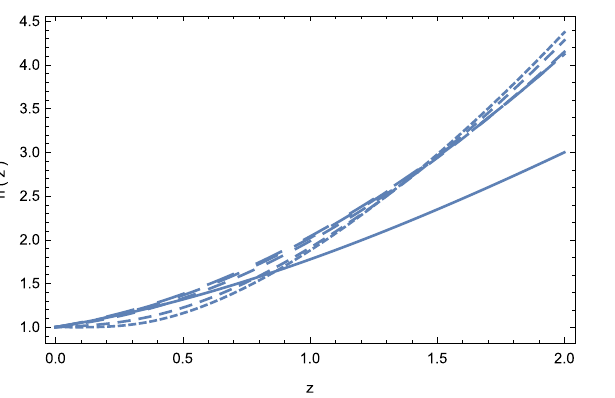
Fig. 6 Variation as a function of the redshift of the matter energy den- sity r ( z ) for the geometry-matter coupling function F for M = 0 . 98, and for different values of α : α = − 0 . 72 (dotted curve), α = − 0 . 77 (short dashed curve), α = − 0 . 80 (dashed curve), α = − 0 . 81 (long dashed curve), and α = − 0 . 82 (ultra-long dashed curve). To integrate the system of cosmological evolution equations we have used the initial conditions h ( 0 ) = 1, (cid:18)( 0 ) = 0 . 455, and (cid:4)( 0 ) = 0 . 335. The solid curve represents the evolution of the matter density in the standard (cid:4) CDM cosmological model